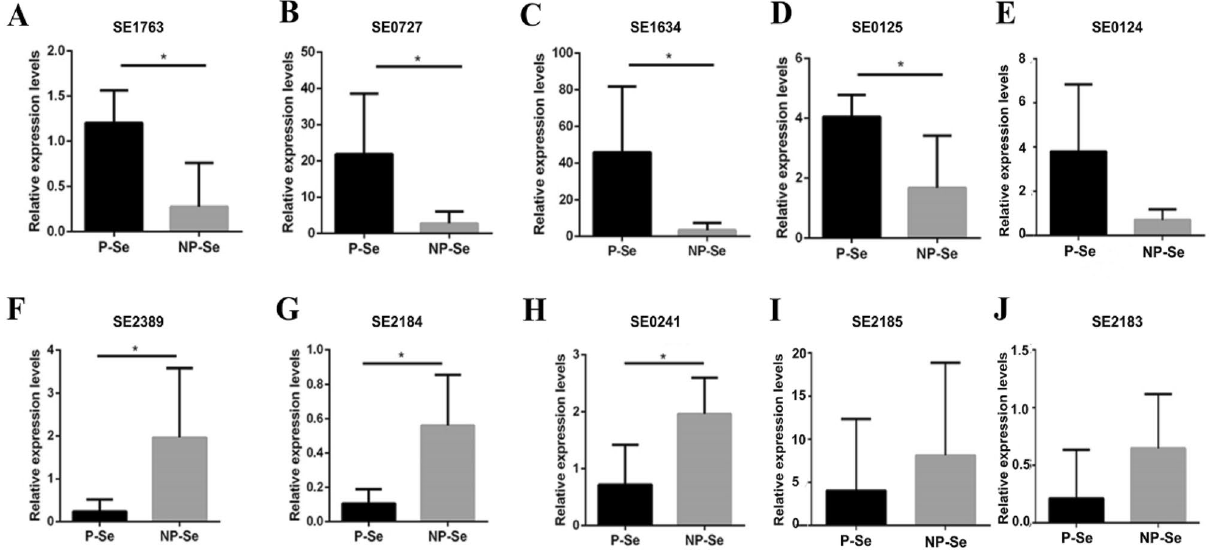
Figure 3. qRT-PCR analysis for validation of expression levels of ten randomly selected DEGs. SE1763 ( A ), SE0727 ( B ), SE1634 ( C ), and SE0125 ( D ) were significantly upregulated in the group of P-Se compared to NP-Se, while SE0124 ( E ) had no significant difference. Similarly, the genes SE2389 ( F ), SE2184 ( G ), and SE0241 ( H ) were significantly downregulated in the group of P-Se compared to NP-Se, while SE2185 ( I ) and SE2183 ( J ) were of no significant difference.* p <